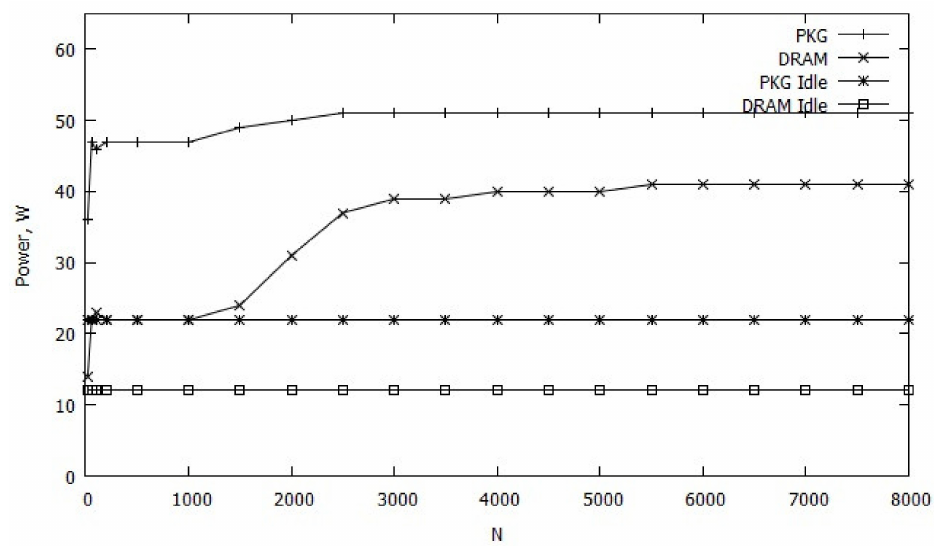
Figure 8. The dependence of the power consumed in the software execution process on the problem dimension (single-pass